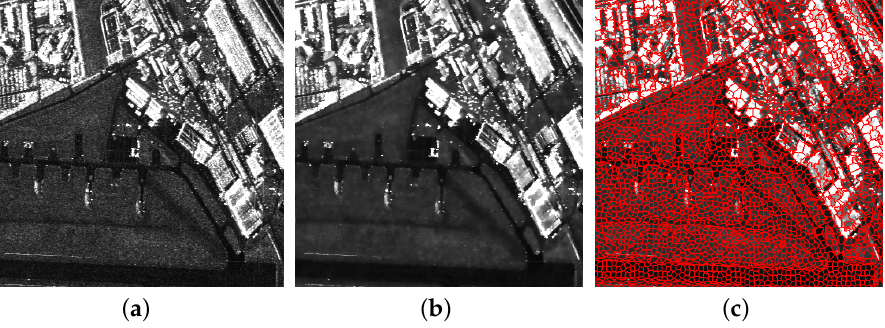
Figure 3. Superpixel segmentation over a cropped area. ( a ) Noisy intensity; ( b ) Filtered by NDSAR-BLF [34]; ( c ) Segmentation with SLIC superpixels